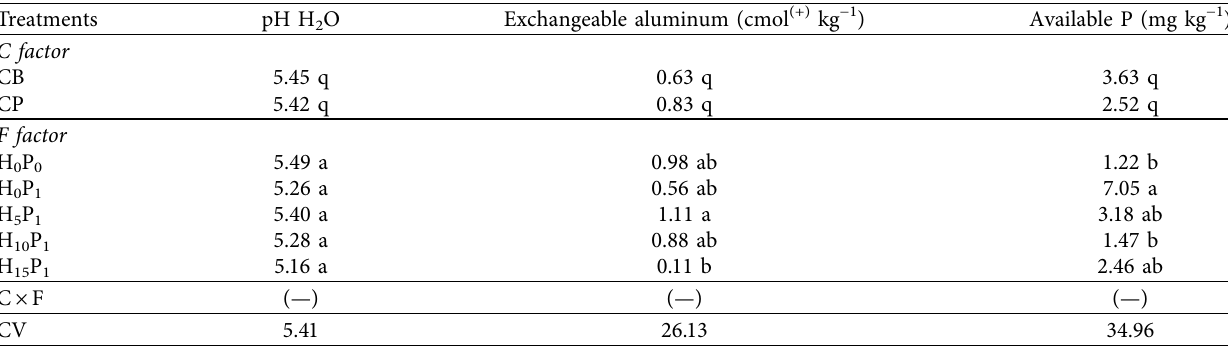
Table 2: Humic acid extracted from the composted manure (MHA) combined with phosphorus (P) fertilizer treatment effects on soil chemical properties 15 weeks after planting for two corn